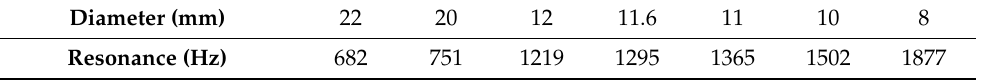
Table 1. Resonance frequency and diameter of different cavities for Helmholtz